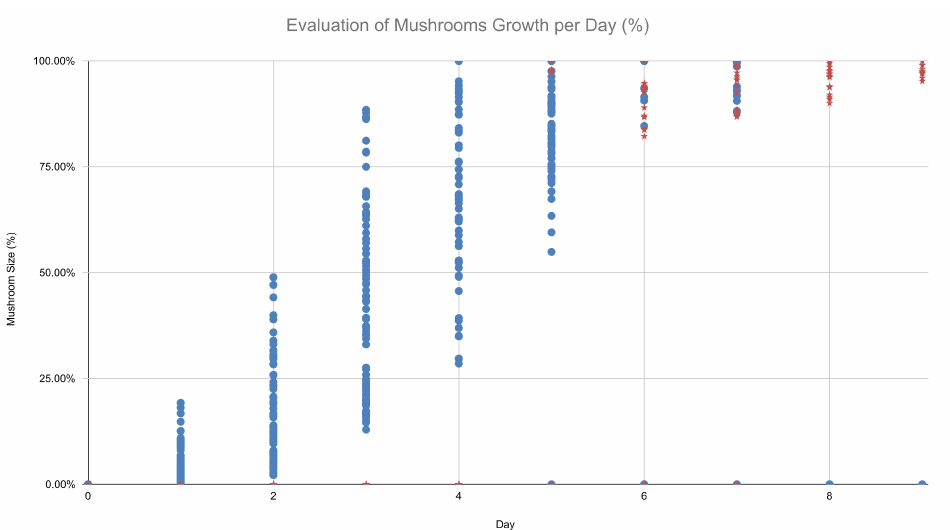
Figure 13. Percentage of the growth rate of all mushrooms. Red marks indicate mushrooms that should have been harvested